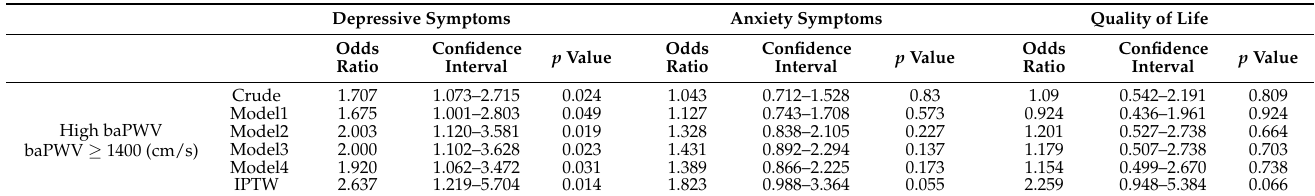
Table 3. Multivariable analysis to assess the association between baPWV and depressive and anxiety symptoms and quality of